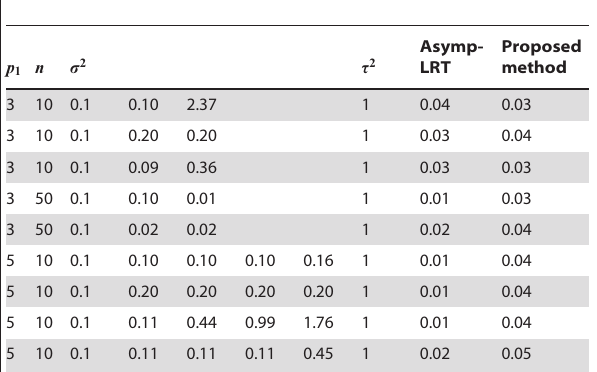
Table 3. Type I errors for heteroscedastic normally distributed data.